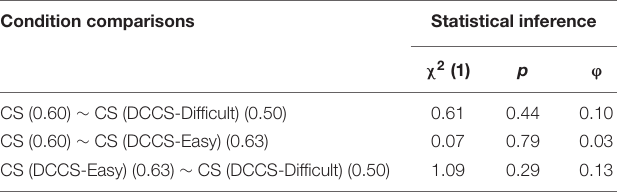
TABLE 3 | Comparison of different conditions involving correlation heuristic reliance among participants. Condition comparisons Statistical